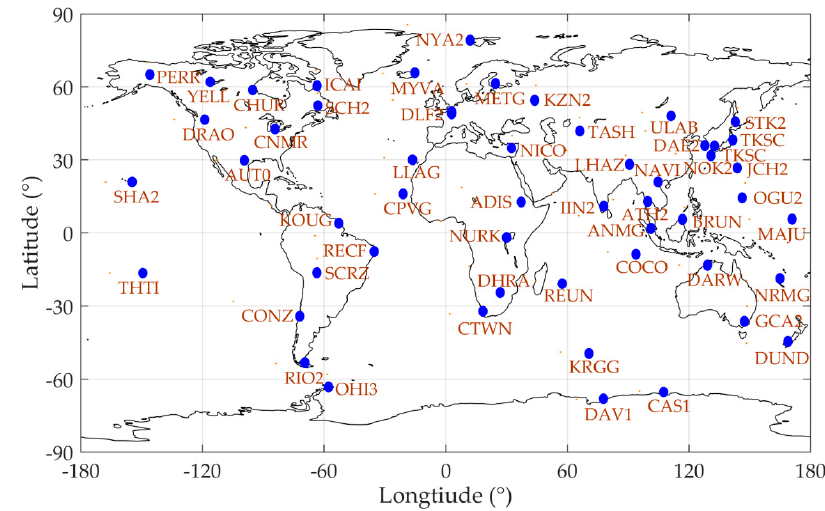
Figure 1. The ground stations for the MADOCA real-time ephemeris